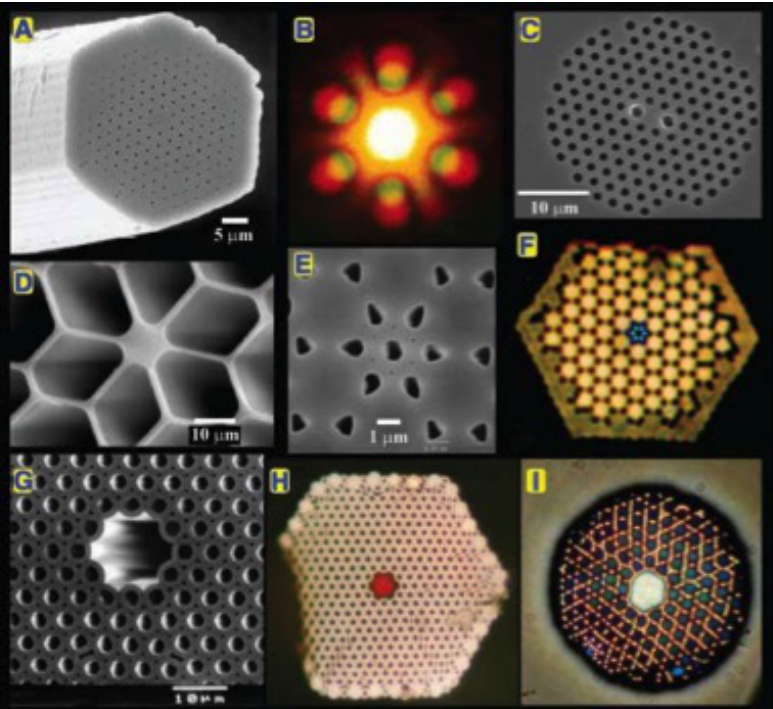
Figure 1. An assortment of optical (OM) and scanning electron (SEM) micrographs of PCF structures. ( A ) SEM of an endlessly single-mode solid core PCF; ( B ) far-field optical pattern produced by the fiber in ( A ) when excited by red and green laser light; ( C ) SEM of a recent birefringent PCF; ( D ) SEM of a small (800 nm) core PCF with ultrahigh nonlinearity and a zero chromatic dispersion at a wavelength of 560 nm; ( E ) SEM of the first photonic bandgap PCF, its core formed by an additional air hole in a graphite lattice of air holes; ( F ) near-field OM of the six-leaved blue mode that appears when the fiber shown in ( E ) is excited by white light; ( G ) SEM of a hollow-core photonic bandgap fiber; ( H ) near-field OM of a red mode in hollow-core PCF (white light is launched into the core); ( I ) OM of a hollow-core PCF with a Kagome cladding lattice, guiding white light, reprinted with permission from